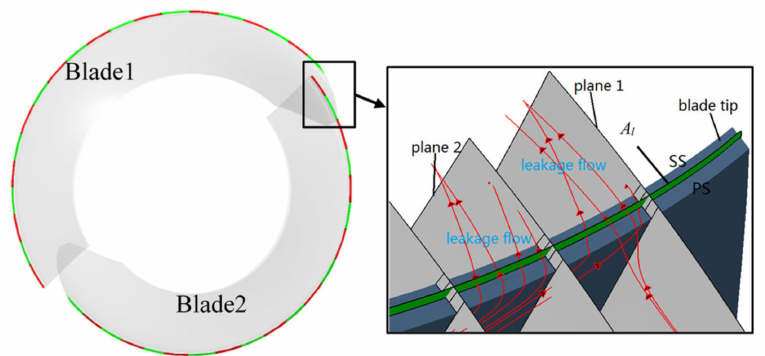
Figure 13. Presentation of the partition in the tip